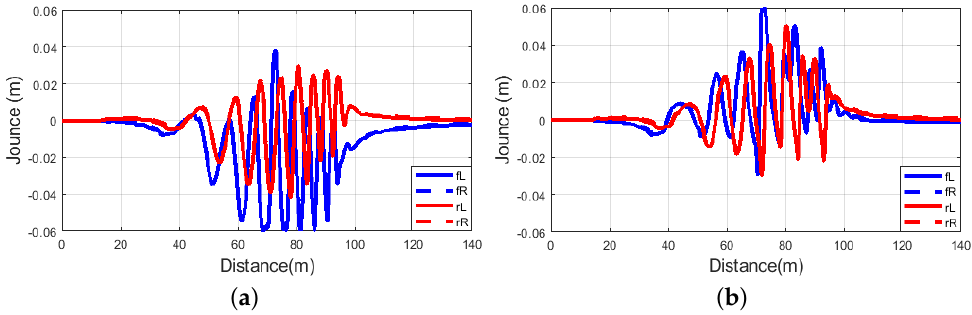
Figure 15. ( a ) Suspension deflection of sine sweep, ρ = 1. ( b ) Suspension deflection of sine sweep, ρ =